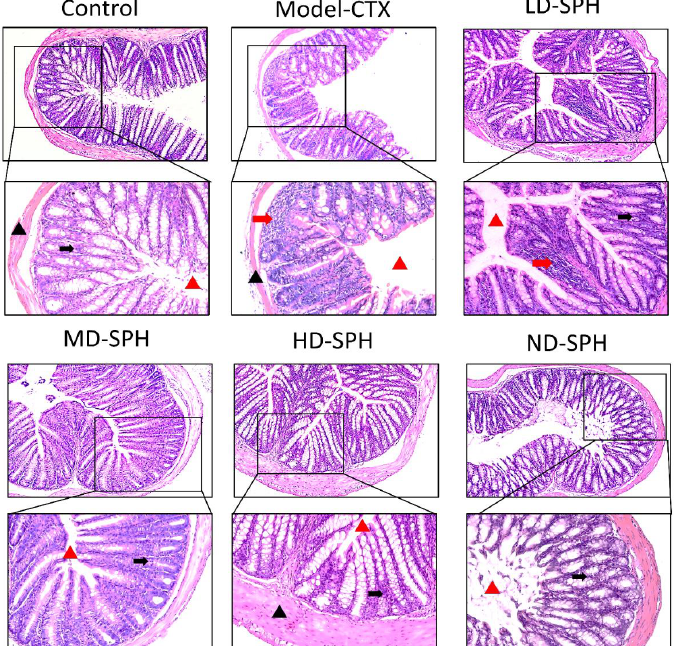
Figure 6. Effect of SPH on colon histologic modifications in mice with dysregulation caused by CTX. Colon sections stained with hematoxylin and eosin (H&E). Inflammatory cells (represented by red arrows), the mucosal space (represented by a red arrowhead), epithelial cells (represented by black arrows), and the epithelial surface (represented by black arrowhead). Magnification 20 × , scale bar: 100 µm.